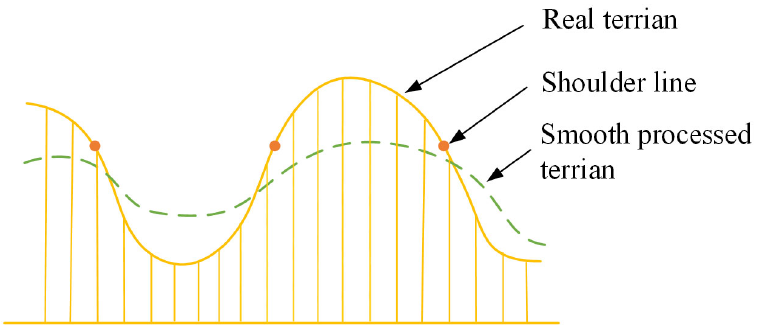
Figure 7. Illustration of smoothed terrain and the position of shoulder